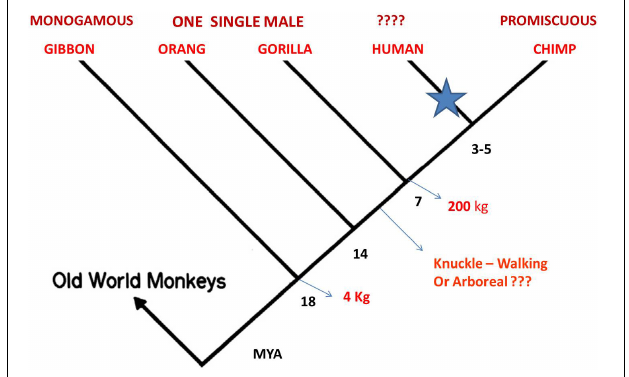
FIGURE 7 | Accepted phylogenic evolution, based on DNA analysis (Lockwood et al., 2004) placing Homo between Gorilla and Chimpanzees. Extra information pertinent to this discussion is shown in red. See text for the proposed explanation for split of the hominin